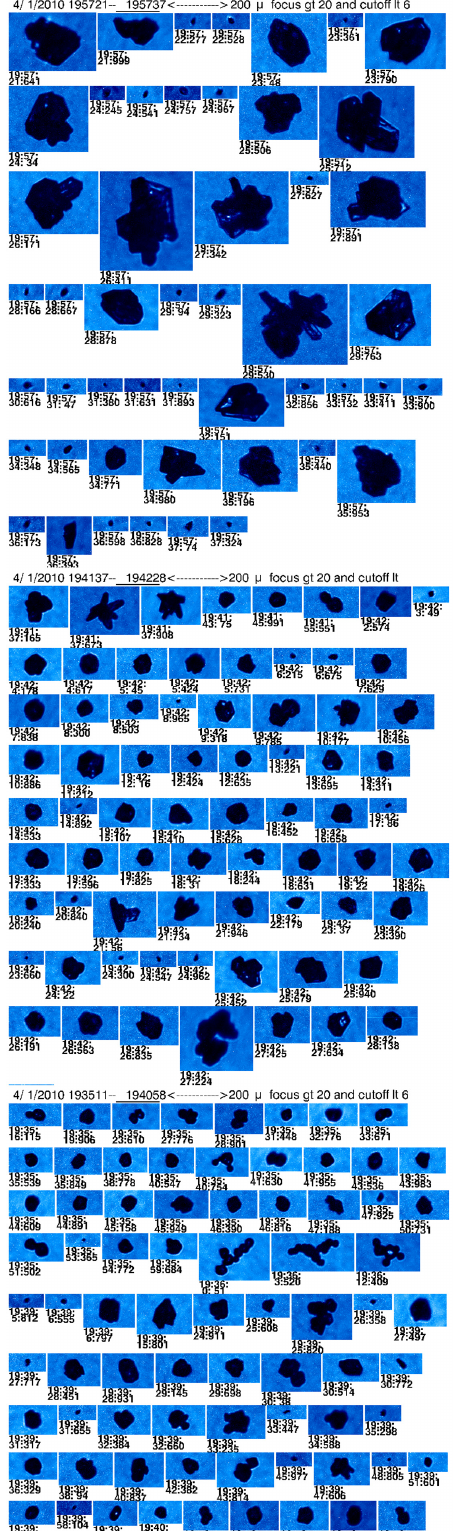
Figure 11. Unclassified ice crystals with sublimated edges imaged on 1 April.